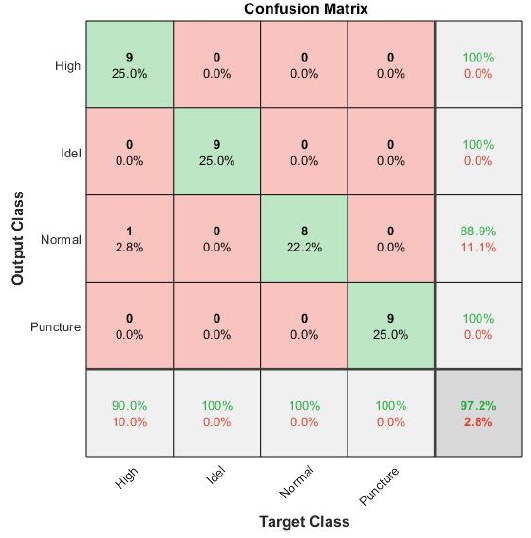
Figure 13. Confusion matrix of TPMS using ResNet-50.